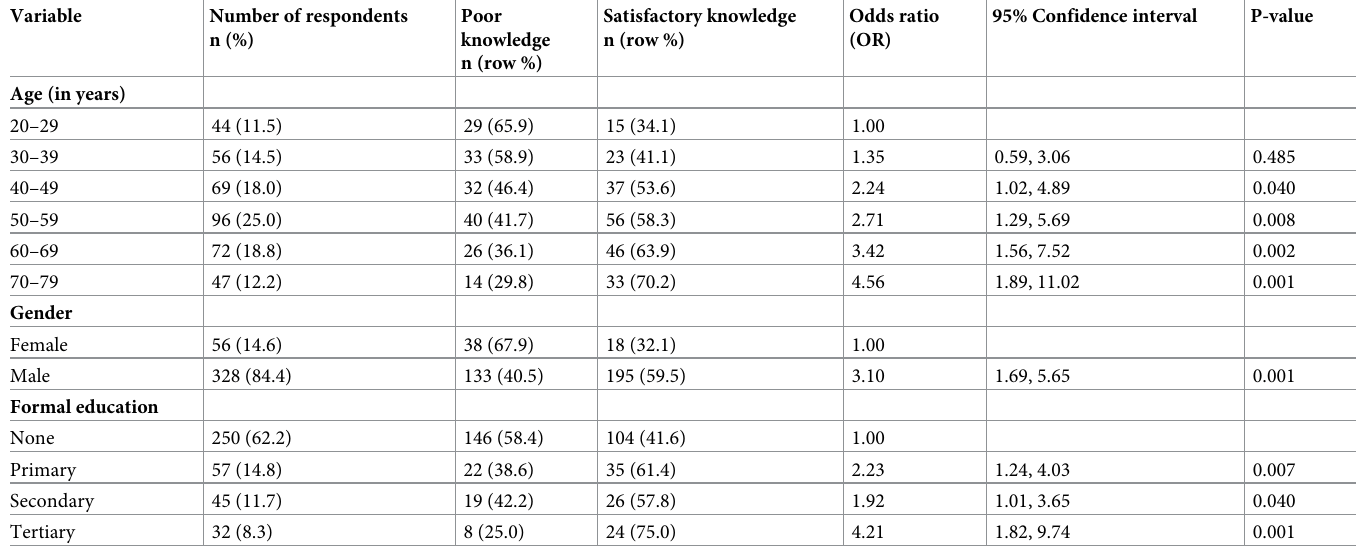
Table 4. Socio-demographic characteristics of Fulani pastoralists associated with knowledge regarding AMU on lactating cows in North-central Nigeria.